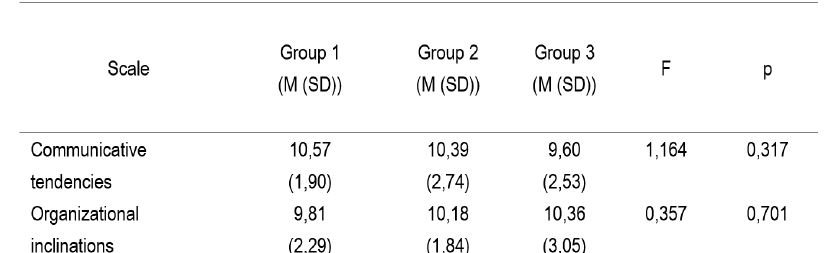
Indicators of communicative and organizational inclinations of mentors with different levels of success (N = 84)